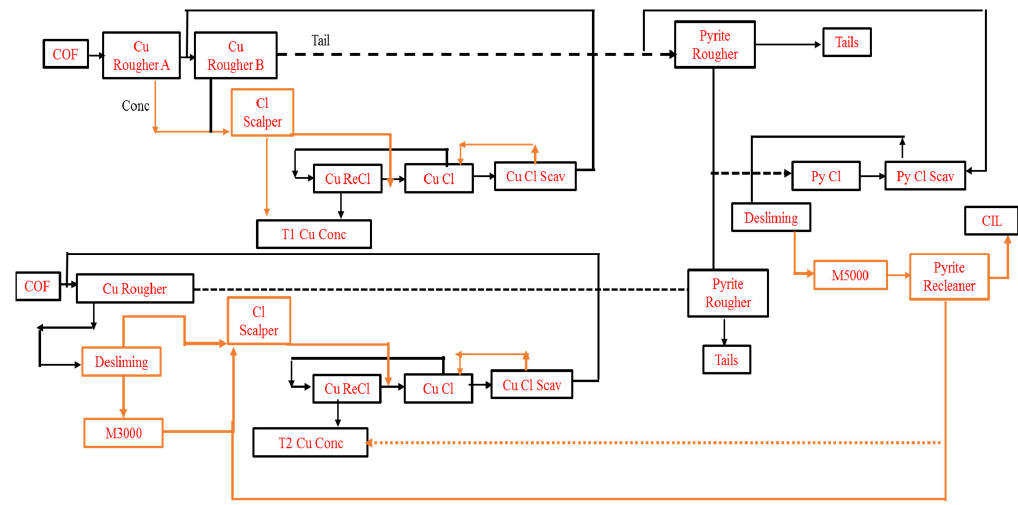
Figure 23. Post-configuration plant flow sheet of Telfer [155].